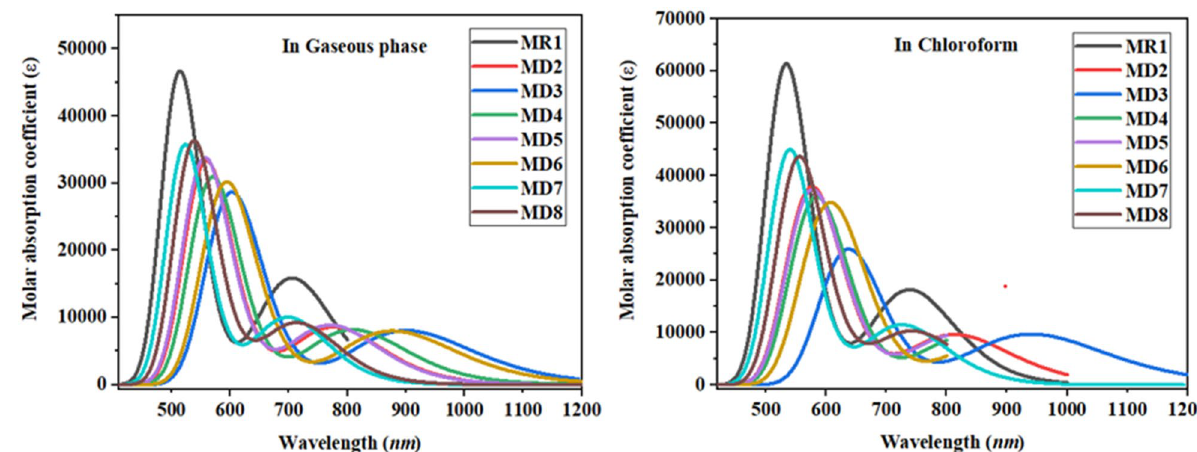
Figure 6. UV–visible absorption spectra of investigated molecules as their names can be seen in above graphs. These graphs are drawn by utilizing Origin Pro 8.5 version (https:// origi npro. infor mer. com/8. 5/). All out put flies of entitled compounds were computed through Gaussian 09 version D.01 (https:// gauss ian. com/ g09ci